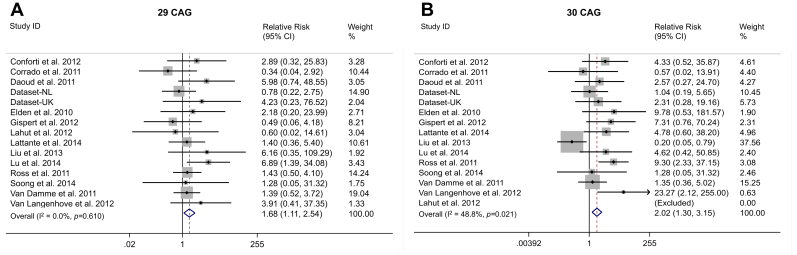
Forest plots of individual alleles between 29 and 33 repeats. Primary analysis of the relative risk of ALS was conducted using low risk-bias case-control studies. UK = new UK data, NL = new Dutch data. Relative risk (RR) was estimated using a fixed effects approach and by comparing individual counts of ATXN2 alleles with the pooled count of alleles with ≤23 repeats as baseline. (A) ATXN2 allele of 29 repeats, RR = 1.68 (1.11, 2.54). No heterogeneity was observed (p-value of heterogeneity >0.05). (B) ATXN2 allele of 30 repeats, RR = 2.02 (1.30, 3.15). One of 15 studies was excluded for absence of carriers of allele 30, both in cases and controls. Significant heterogeneity was observed (p-value of heterogeneity <0.05). (C) ATXN2 allele of 31 repeats, RR = 2.96 (1.73, 5.05). One of 15 studies was excluded for absence of carriers of allele 31, both in cases and controls. No heterogeneity was observed (p-value of heterogeneity >0.05). (D) ATXN2 allele of 32 repeats, RR = 8.37 (4.02, 17.43). Two of 15 studies were excluded for absence of carriers of allele 32, both in cases and controls. No heterogeneity was observed (p-value of heterogeneity >0.05). (E) ATXN2 allele of 33 repeats, RR = 4.73 (1.92, 11.63). No heterogeneity was observed (p-value of heterogeneity >0.05). Abbreviation: ALS, amyotrophic lateral sclerosis.